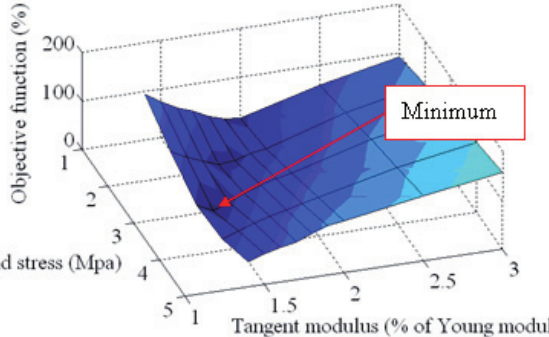
Fig. 8. Zoom on the minimum of the objective function.